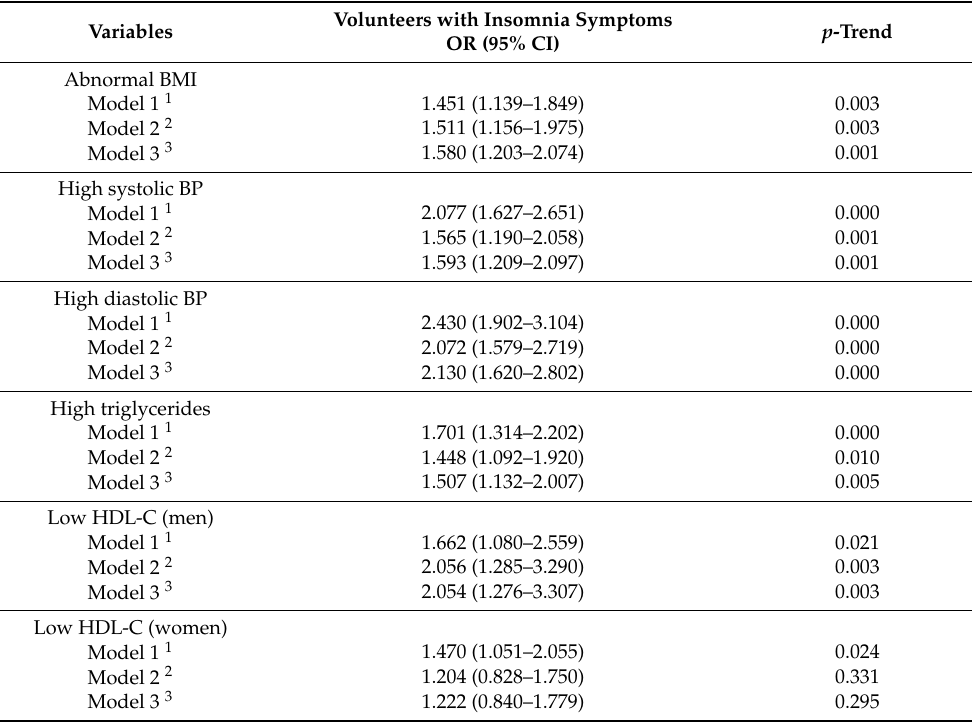
Table 3. Odds ratios (95% CI) of the components of MetS and insomnia symptoms. ORs: odds ratios (N = 1252).